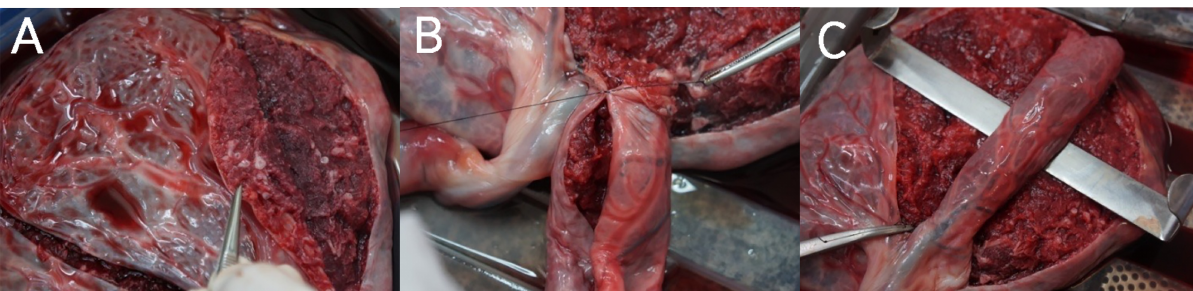
Figure 1 - Surgical preparation of human placenta in a varicocele model. A) Cutting 1.0 cm deep and folding the placenta stroma. B) Suturing the folded borders. C) Spermatic funiculus simulation.